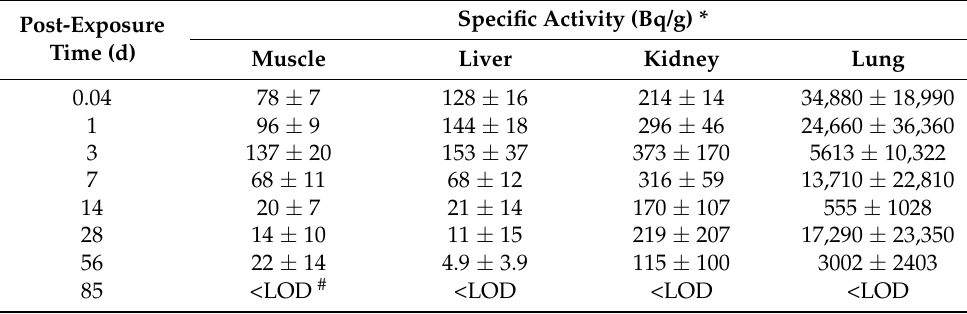
Table 1. Specific activity of muscle, liver, kidney and lung samples.